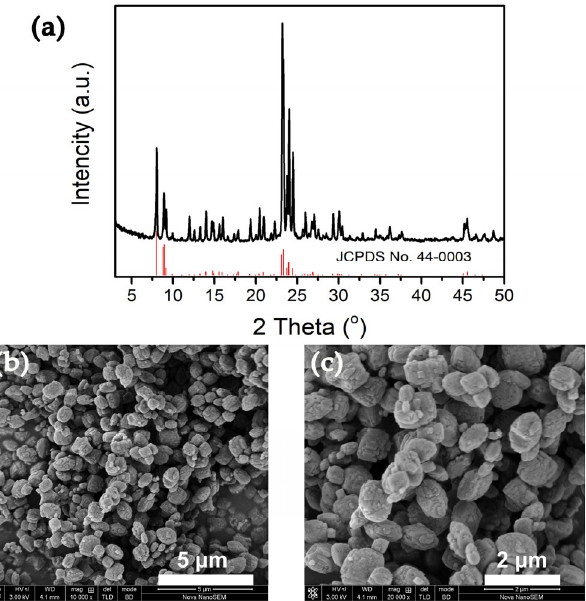
Figure 9. XRD patterns ( a ) and FE ‐ SEM micrographs ( b , c ) of ZSM ‐ 5 ‐ 100 ‐ 200 synthesized with silica sol.